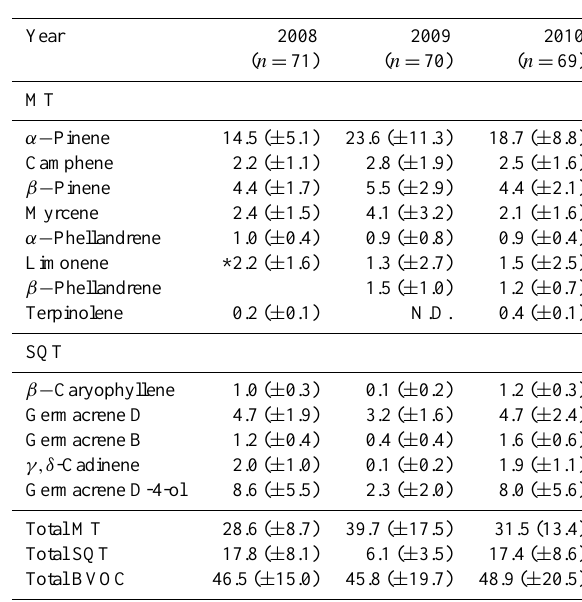
Table 1. The average concentration (µmoldwg − 1 ) with standard deviation in needles of understory white pine trees at UMBS.